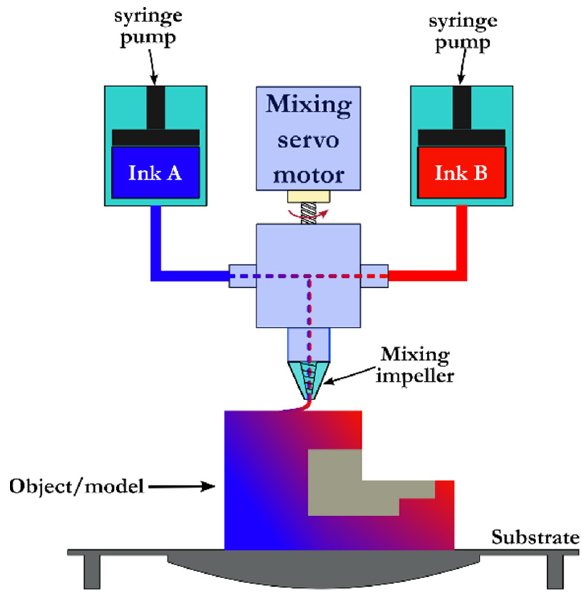
Figure 7. Process description of DIW .